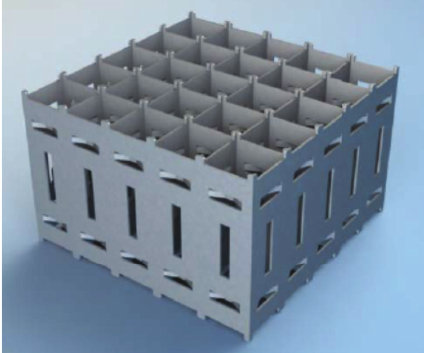
Figure 8: View of nonmixing vane spacer grid.